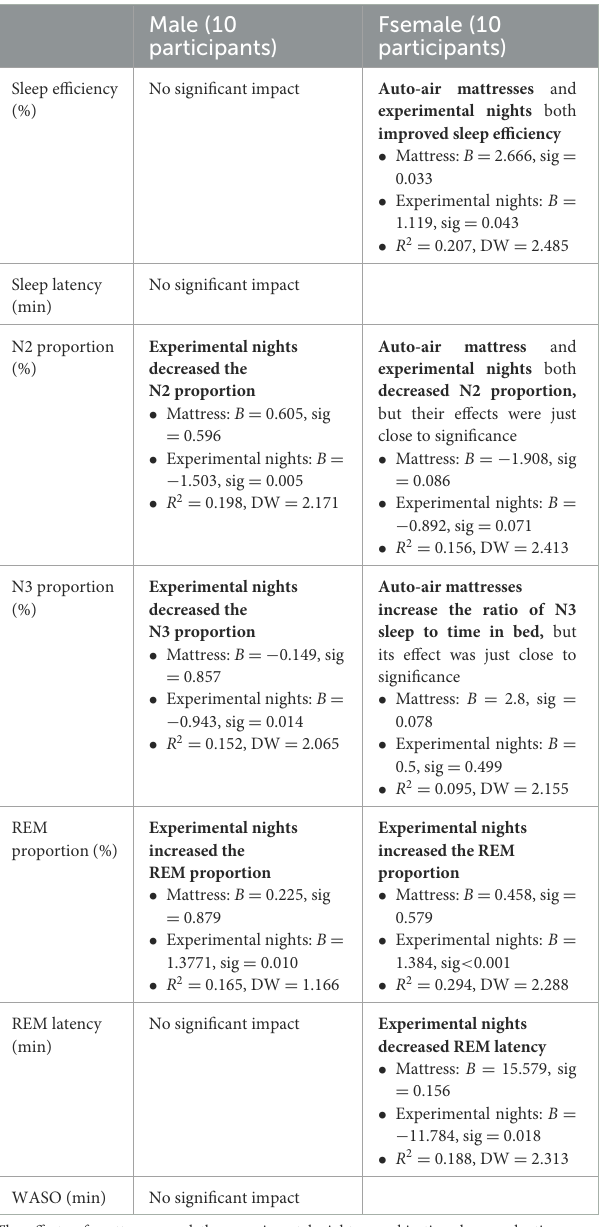
TABLE 3 Objective sleep evaluation of the whole night’s